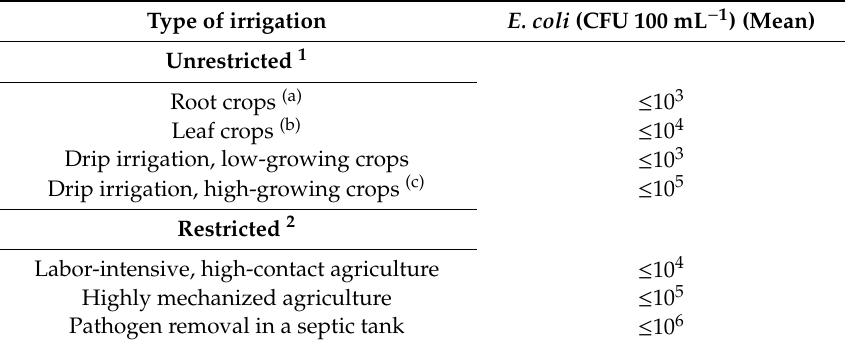
Figure 4. Variation in the population of E. coli in wastewater after passing through drip laterals under different treatments. Vertical bars for each column represent standard deviations ( n = 3) of the means. Means of different treatments followed by the different lowercase letter (a–c) are significantly different ( p < 0.05). Table 3. Recommended minimum verification monitoring of E. coli performance targets for wastewater use in agriculture (modified from WHO, 2006), [50].